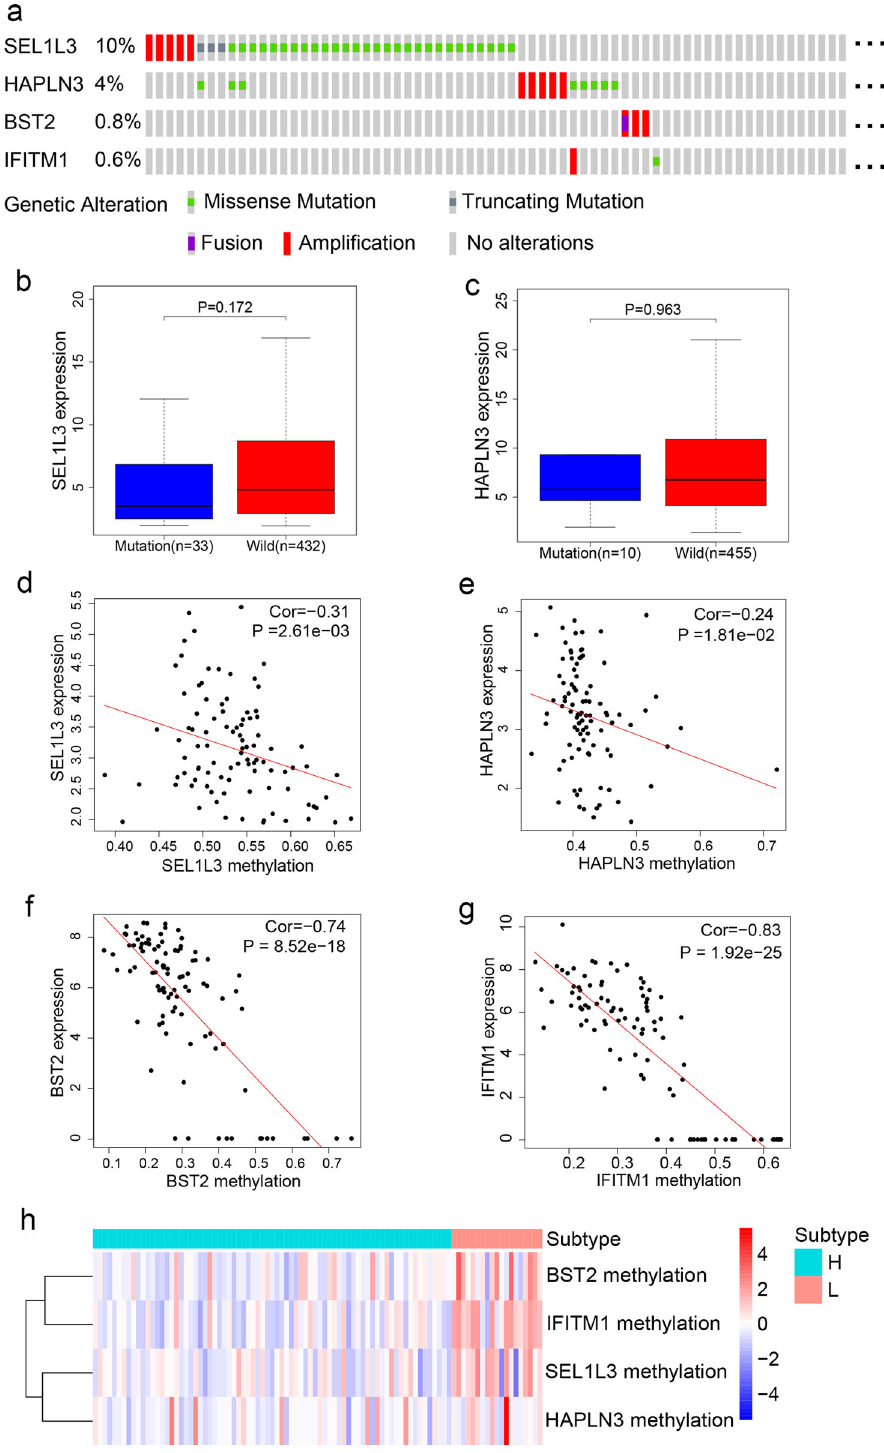
Fig. 6 Multi-omics analyses of the four genes in the TIR signature. a The mutational status of SEL1L3 , HAPLN3 , BST2 , and IFITM1 in TCGA SKCM patients. Data were from the cBioPortal database. b , c mRNA levels of SEL1L3 ( b ) and HAPLN3 ( c ) in the TCGA SKCM patients strati fi ed by the mutation status. Statistical signi fi cance was determined by the Wilcoxon test. SEL1L3 and HAPLN3 were not analyzed due to the very small sample size in the mutation group. The boxplot consists of a box and a set of whiskers. The box is drawn from the fi rst quartile (25th percentile) to the third quartile (75th percentile) with a horizontal line drawn in the middle to denote the median. The lowest point is the minimum of the dataset and the highest point is the maximum of the dataset. d – g Correlations between mRNAs levels and methylation levels of SEL1L3 ( d ), HAPLN3 ( e ), BST2 ( f ), IFITM1 ( g ) in TCGA SKCM patients. Statistical signi fi cance was determined by the Spearman correlation test. h Heatmap of SEL1L3 , HAPLN3 , BST2 , and IFITM1 methylation levels in H and L subtypes. Rows represent genes and columns represent